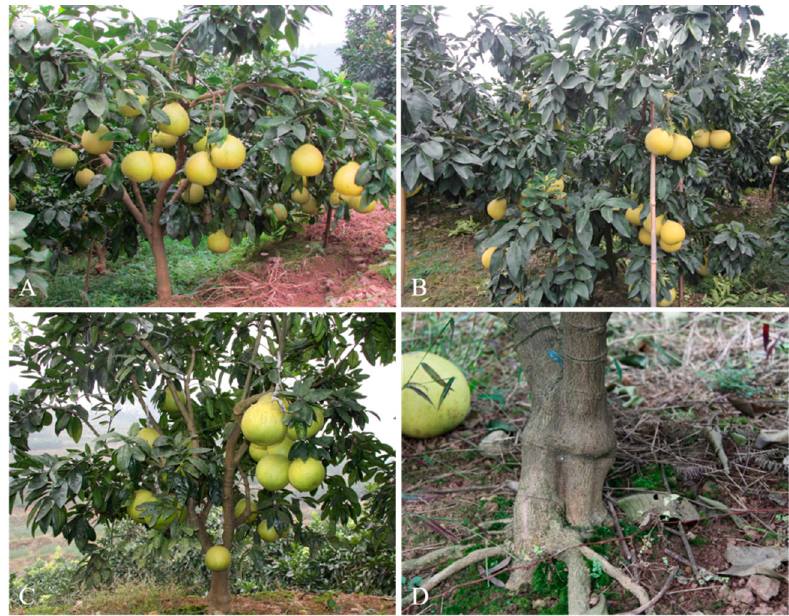
Figure 5. Fruit character of ‘Guanxi Miyou’ grafted onto three citrus rootstocks. ( A ) ‘Guanxi Miyou’ grafted onto ‘Pujiang xiangcheng’. ( B ) ‘Guanxi Miyou’ grafted onto sour pummelo. ( C ) ‘Guanxi Miyou’ grafted onto trifoliate orange. ( D ) Graft union of Gx/Pt.